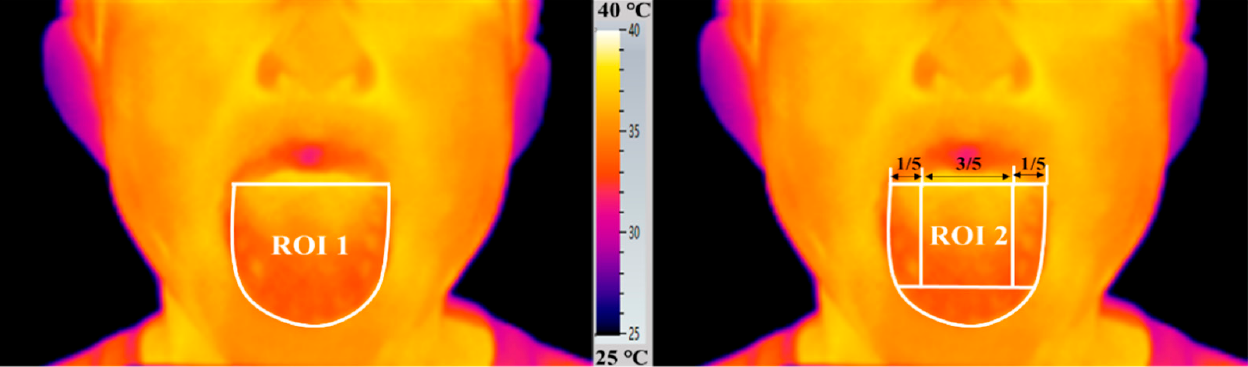
Figure 2. The regions of interest (ROIs) chosen for statistical analysis of the thermographic data. In each tongue image, the maximal temperature (T Max), the minimal temperature (T Min), and the average temperature (T Aver) were calculated for ROI 1 and ROI 2.